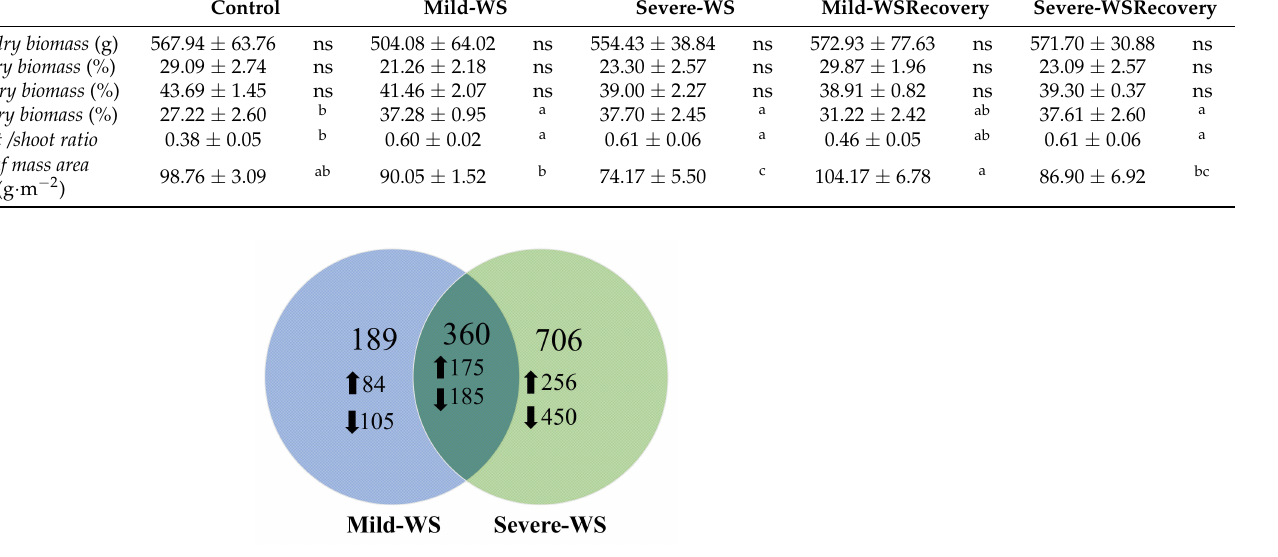
Figure 4. Venn diagram of differentially expressed genes. Numbers of common and specific differ- entially expressed genes (DEGs) obtained in the microarray analysis of ‘Dusa’ avocado rootstocks subjected to two different levels of water stress (50% of Fc, mild-WS and 25% of Fc, severe-WS). Statistically significant DEGs ( p < 0.05) were filtered above and below fold change values of 2 and − 2, respectively. Unique DEGs are shown only in one of the two circles, while shared transcripts are shown in their intersection. Arrows indicate the number of genes up- and downregulated. Table 2. qRT-PCR and microarray expression data of selected contigs from ‘Dusa’ avocado rootstock under two different levels of water stress: mild-WS (50% of Fc) and severe-WS (25% of Fc). Numbers in bold indicate statistically significant results ( p <